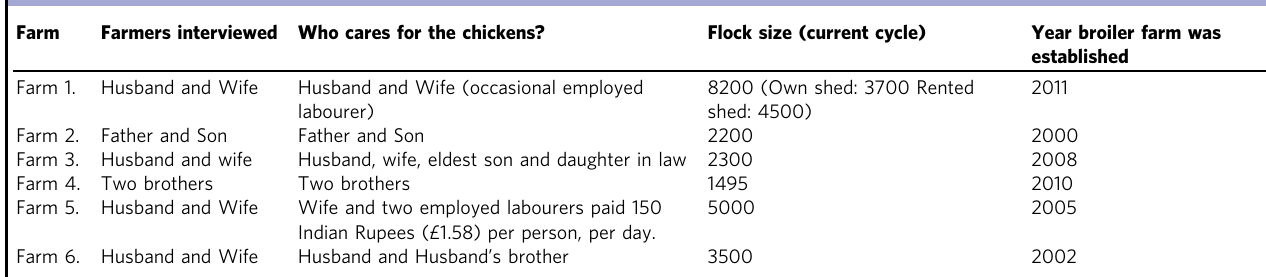
Table 1 An overview of characteristics of farms in this